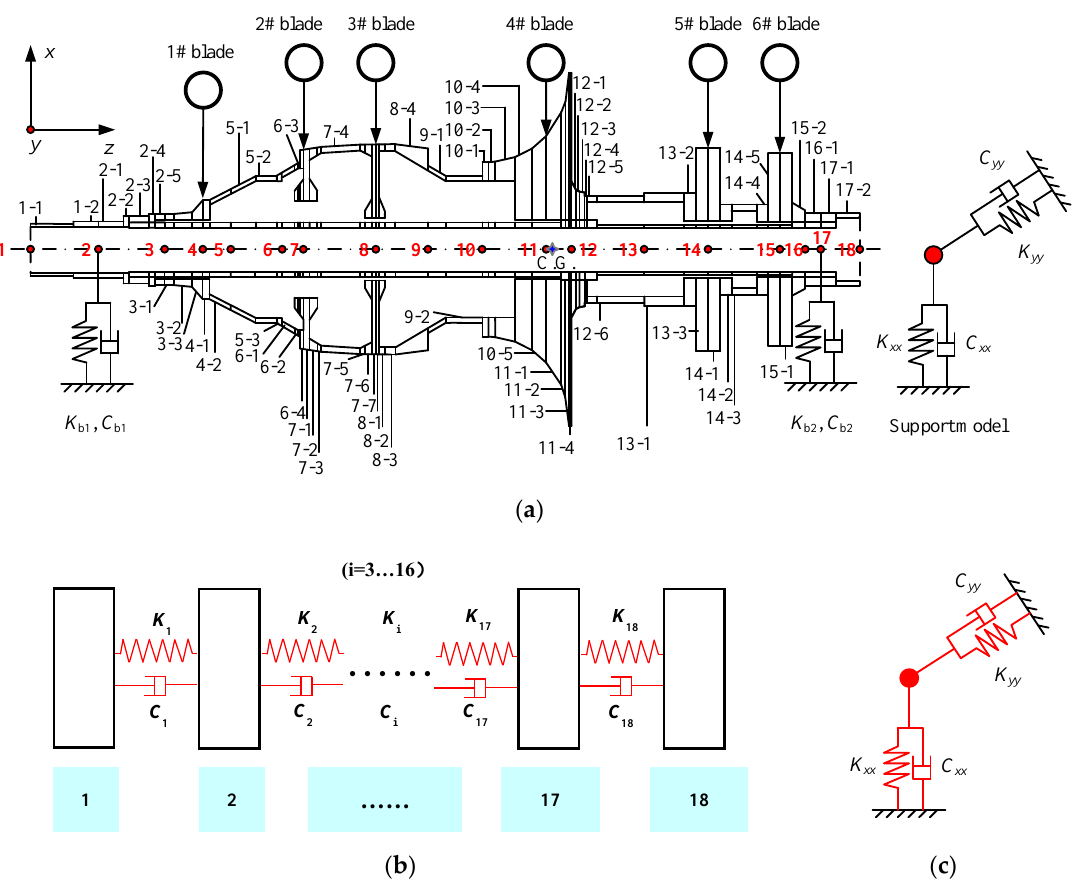
Figure 3. Dynamic model of the rotor-support system with 18 master nodes. ( a ) FE model with master- and sub-elements. ( b ) The mechanical model equal to ( a ). ( c ) Supporting